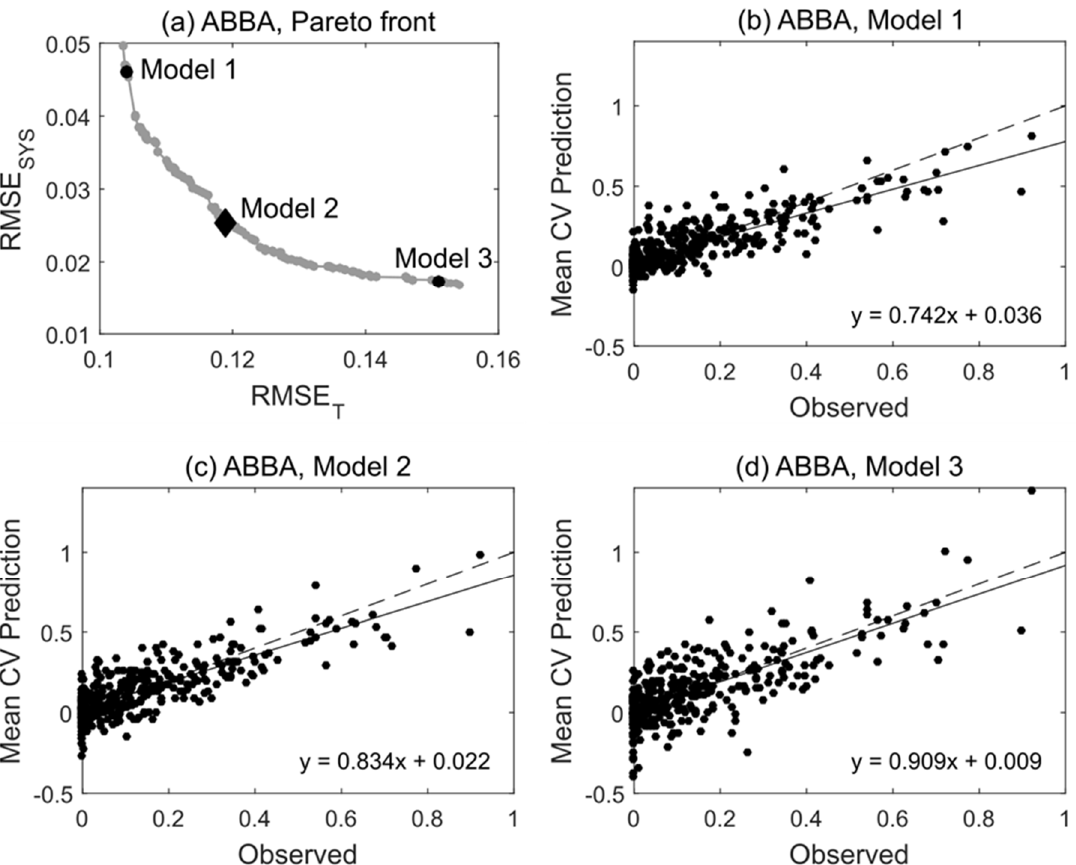
Figure 4. Pareto front and select Pareto-optimal models for species ABBA (balsam fir). ( a ) The approximate Pareto front obtained by MOSVR (including parameter, variable, and sample selection). ( b-d ) Plots of predicted vs. observed values for selected models lying at different positions along the Pareto front. For comparison to other prediction methods and for use in forest mapping, a model was selected from the midsection of the front (Model 2). Predicted values are mean values obtained from 100 repetitions of a 10-fold CV.